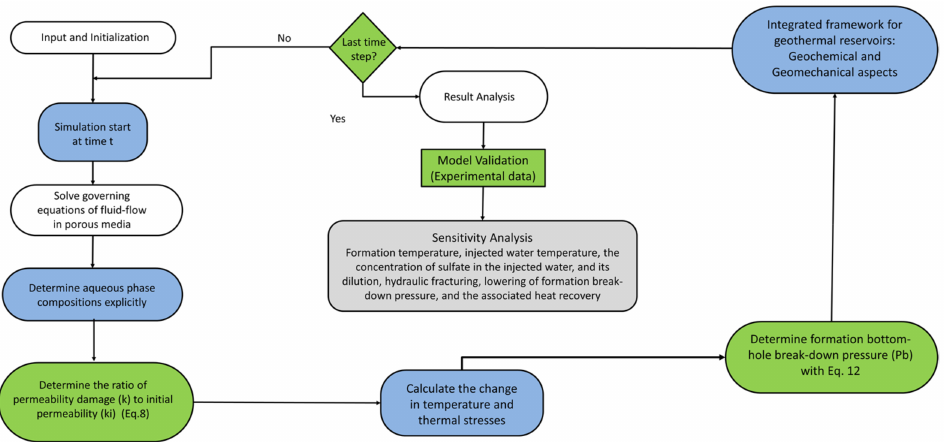
Figure 1. Flowchart of geochemical and geomechanics based formation damage analysis in geother- mal